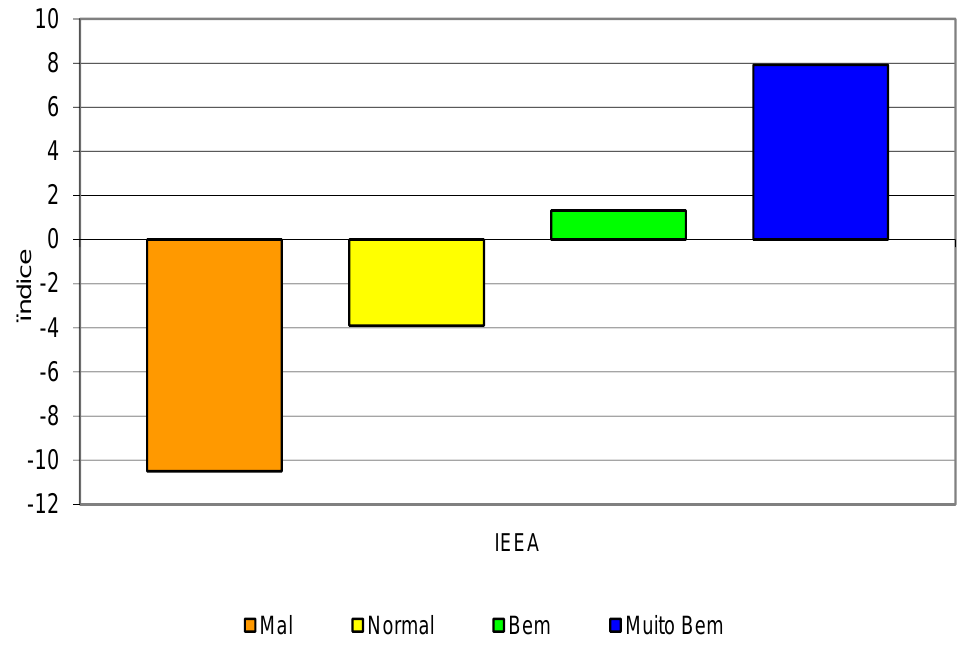
Figura 3. IEEA para o fator “Como está o relacionamento com suas